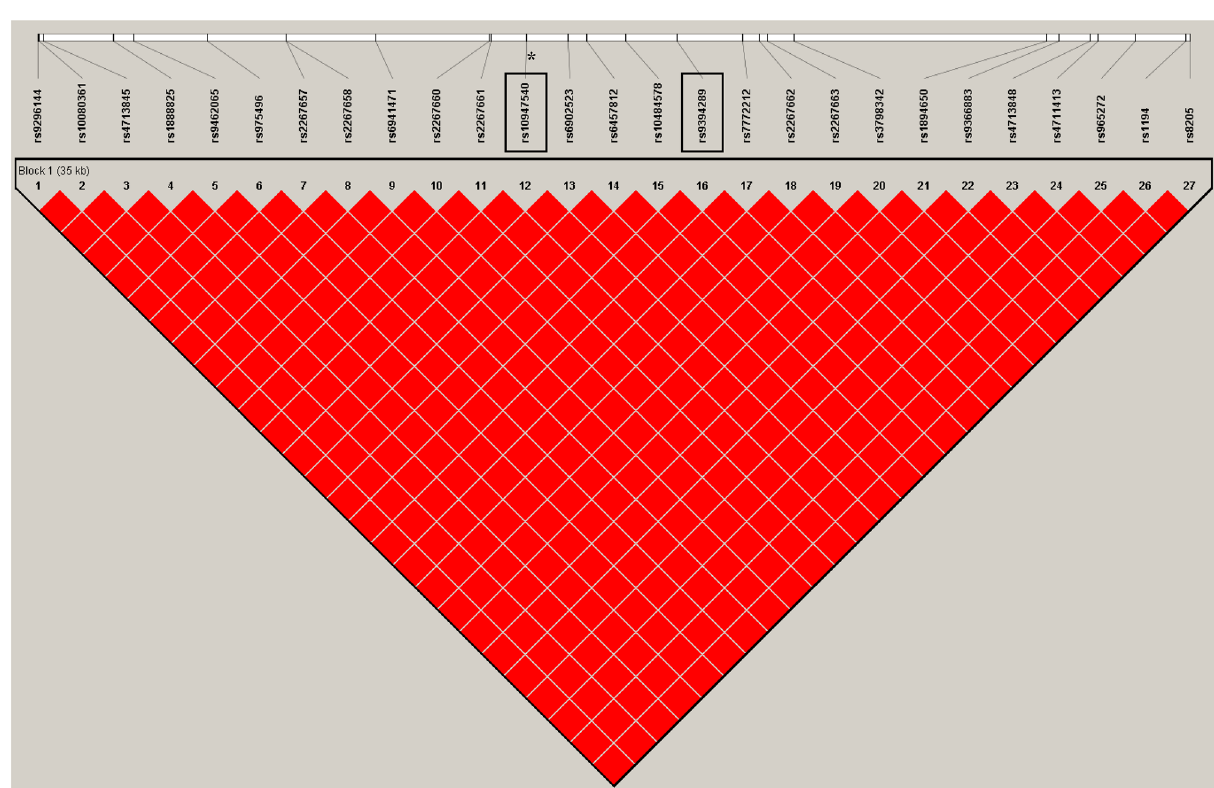
Figure 1. The LD maps of the 28 identified SLE-associated SNPs in 103 Chinese Han Beijing individuals according to 1000 genome project. The degrees of LD were estimated by CI method using Haploview4.2 (Cambridge, MA, USA) and a standard color scheme (D’/LOD) is used to display the LD pattern. Top signals ( p = 1.31 × 10 −5 ), rs10947540, rs9394289, rs2267663, rs1894650, rs9366883 were highlighted by black boxes and were in high linkage (D’ = 1.0, r-square = 1.0). The variant, rs10947540, further replicated in independent cohort was marked with